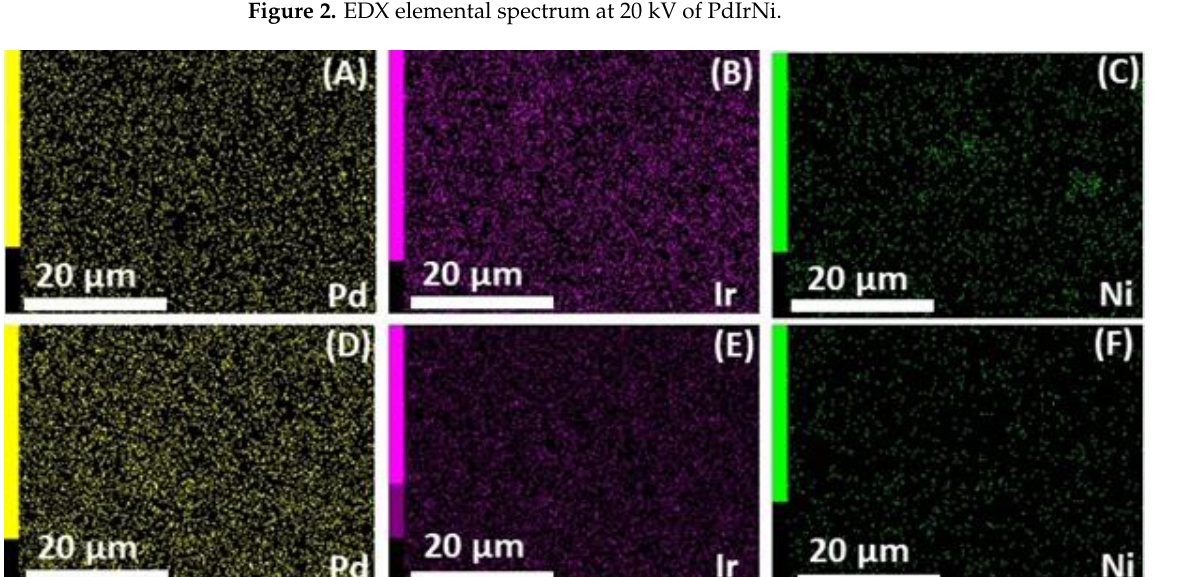
Figure 3. EDX Pd, Ir, and Ni maps of PdIrNi/C ( A – C ) and Pd 4 Ir 2 Ni 1 /C ( D – F ). Table 4. X-ray photoelectron spectroscopy (XPS) data of valence state and metal/oxide atomic con- centration measurements in Pd/C, Pd 4 Ir 2 Ni 1 /C and PdIrNi/C.